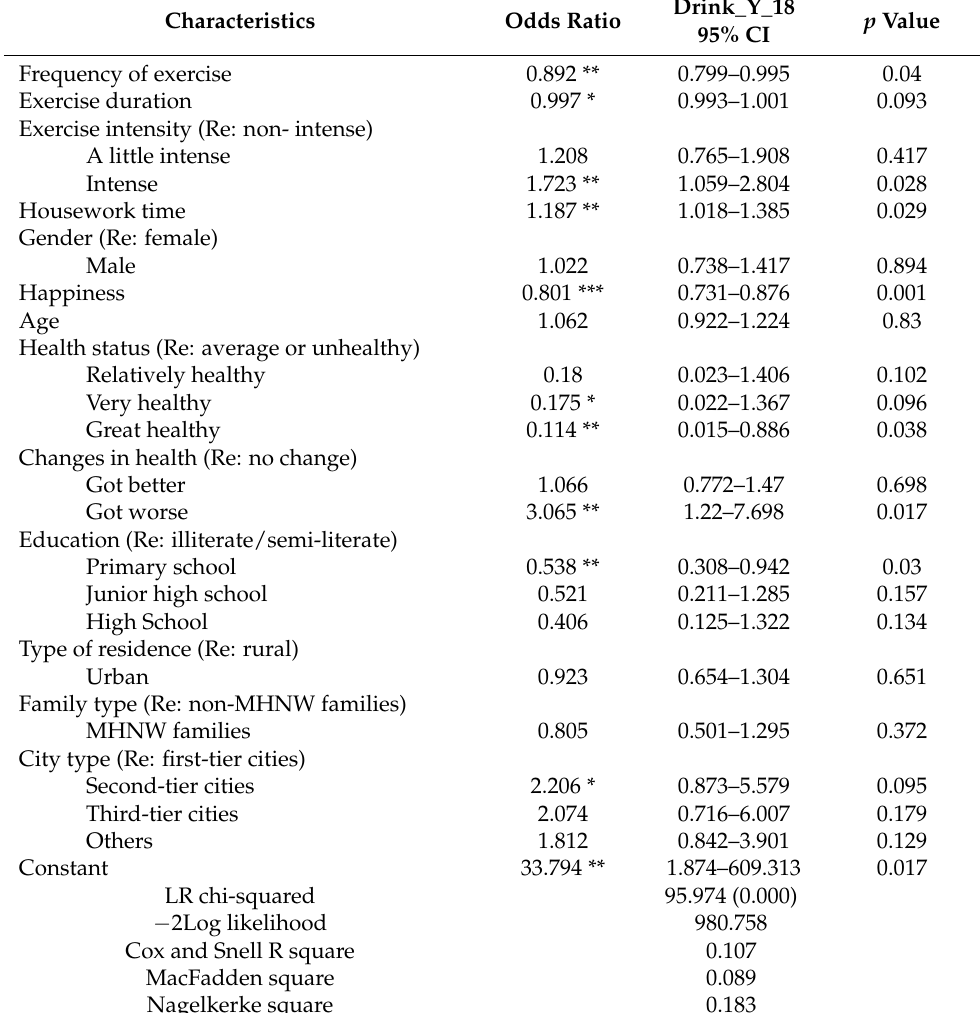
Table 2. Multivariate logistic regression